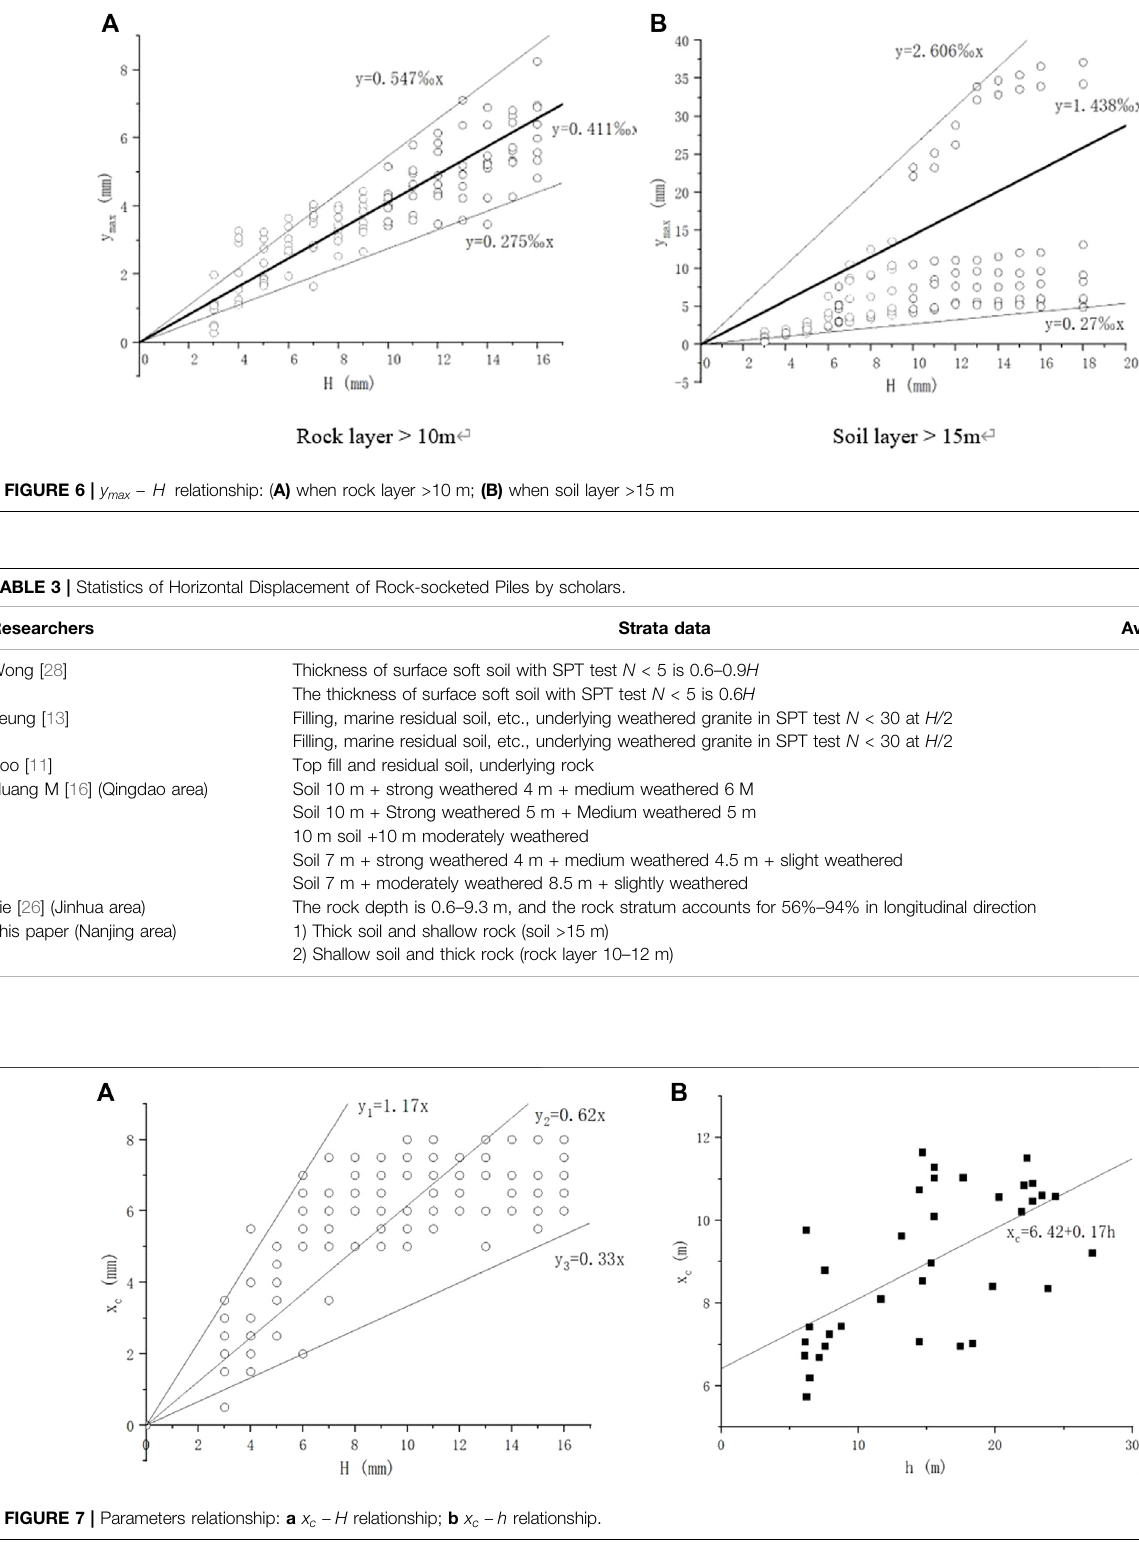
Frontiers in Physics |